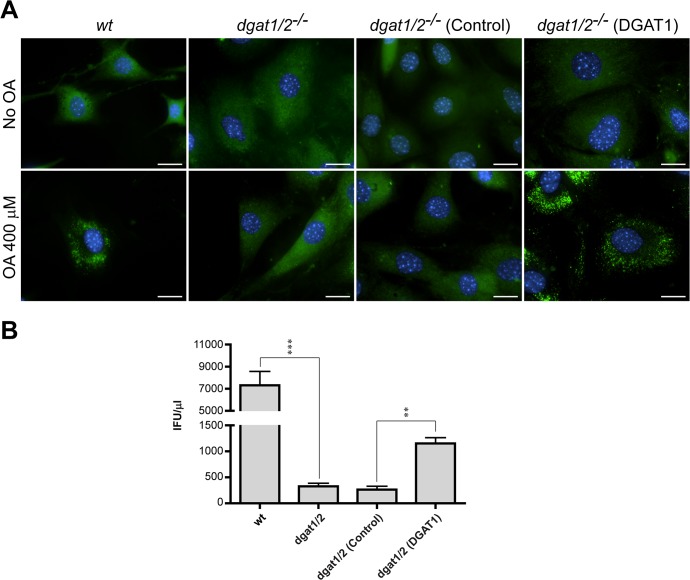
Production of C. trachomatis infectious progeny is impaired in cells devoid of LDs.
(A) Representative fluorescence microscopy pictures of wild type MEF (wt), the diacylglycerol-acyltransferases 1 and 2 double knock-out (dgat1/2
-/-), dgat1/2
-/- complemented with empty vector [dgat1/2
-/- (Control)] and dgat1/2
-/- complemented with DGAT1 [dgat1/2
-/- (DGAT1)], stimulated or not with oleic acid (OA) 400 μM for 14 h, as indicated. For visualization of LDs, neutral lipid-specific BODIPY 493/503 staining was used (green). Hoechst staining was used to visualize DNA (blue). Bar sizes (20 μm) are shown. Note that dgat1/2
-/- cells are devoid of LDs even under stimulation with OA, whereas LD formation is restored in dgat1/2
-/- (DGAT1). (B) Impact of impaired LD biogenesis on chlamydial replication was evaluated by measuring bacterial yields expressed as inclusion forming unit per microliter (IFU/μl) in IFU assays, as detailed in Materials and Methods. Compared to wt cells, chlamydial replication was reduced in dgat1/2
-/- whereas increased chlamydial yields were observed in dgat1/2
-/- (DGAT1) compared to dgat1/2
-/- (Control). Bars represent the mean and standard deviation. Data is representative of at least 3 independent experiments. Asterisks indicate statistically significant differences (***p<0.001; **p<0.01) as calculated by unpaired, two-tailed T-test. Input IFUs (mean ± standard deviation) were very similar for all cell types: wt, 19104 ± 1207; dgat1/2
-/-, 18758 ± 1008; dgat1/2
-/- (Control), 18691 ± 1163; dgat1/2
-/- (DGAT1) 18484 ± 1128.